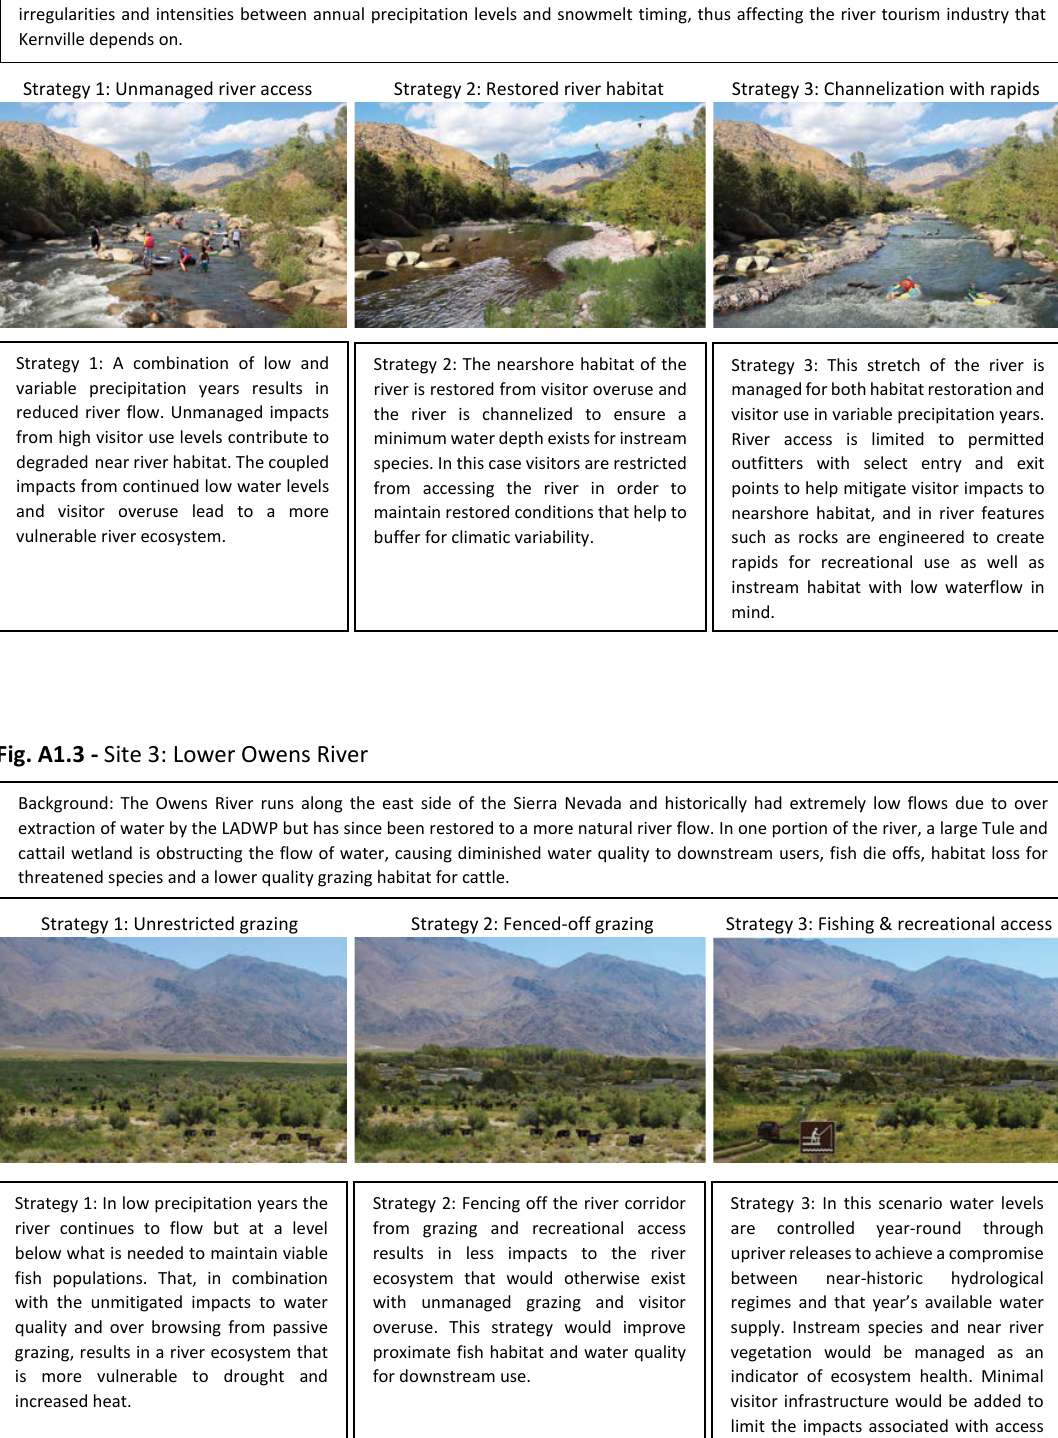
Fig. A1.2 - Site 2: Upper Kern River